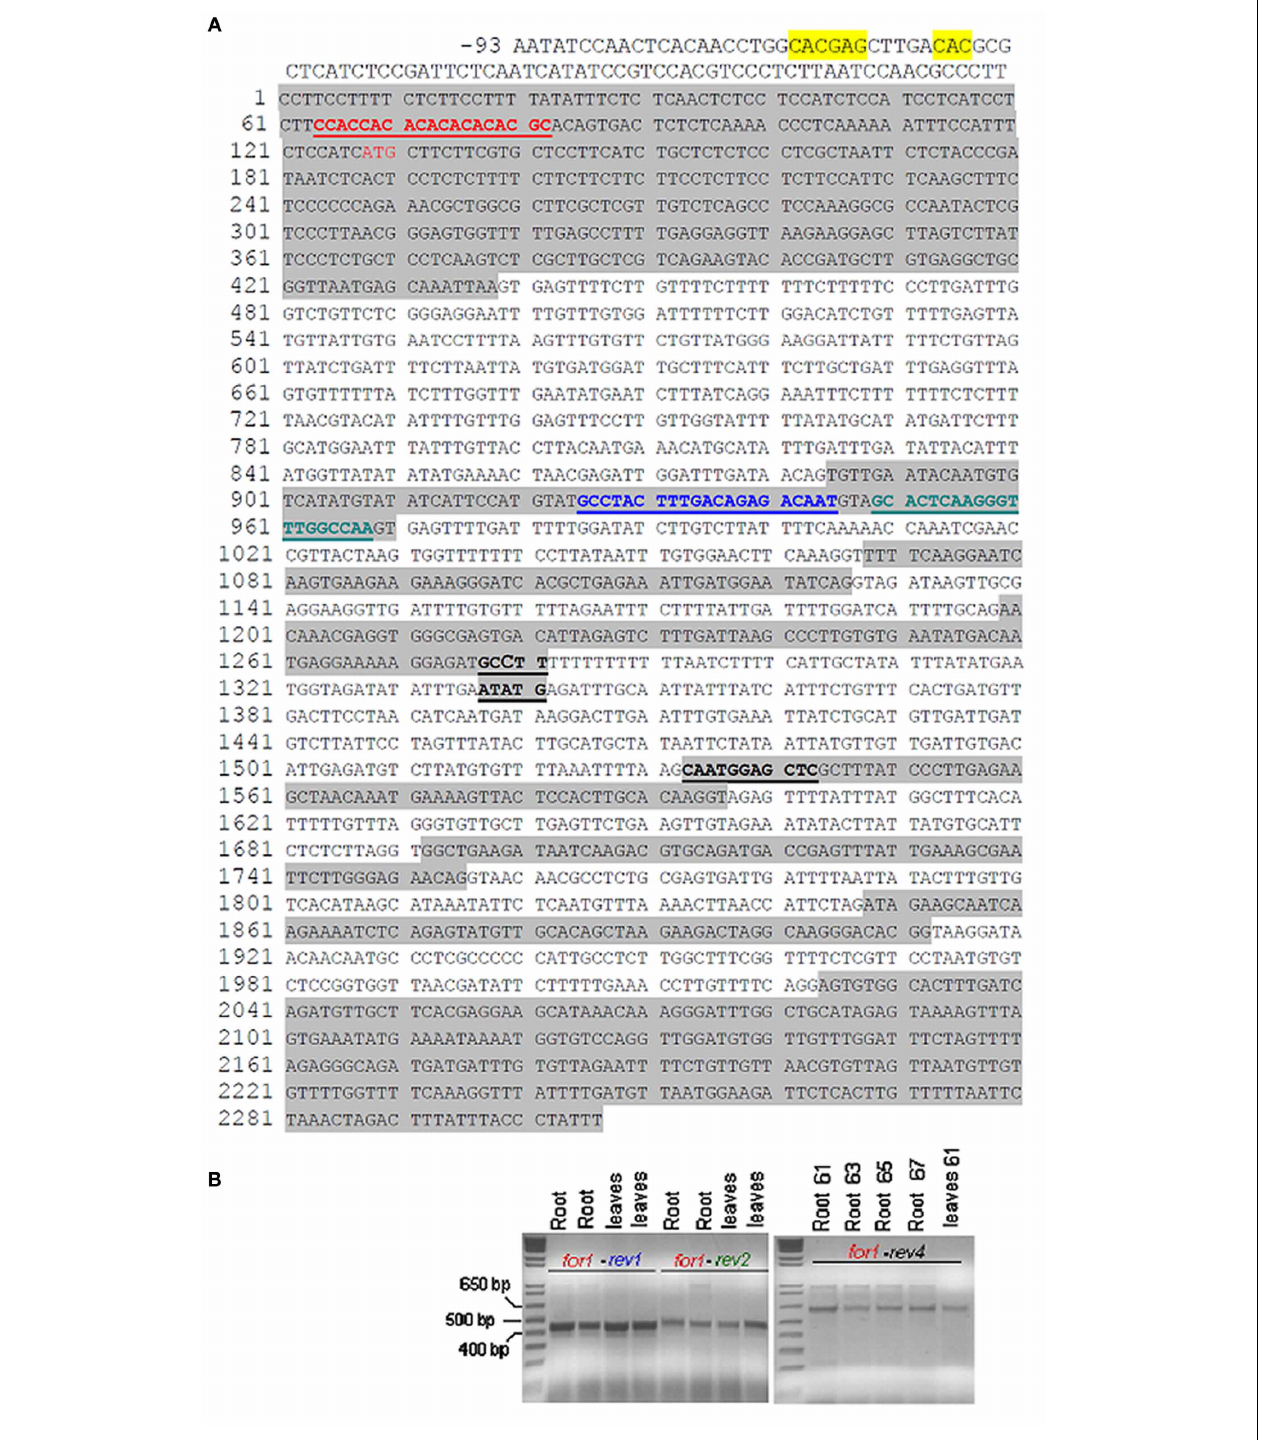
Cucsafor1-Cucsa-rev2, with either two independent RNA extracts from Fe-excess cucumber roots or two independent RNA extracts from Fe-excess leaves. The Kb ladder Plus (Invitrogen) has been loaded in the far left lane. Right panel: RT-PCR reactions with primer pair Cucsafor1-Cucsa-rev4, with RNA purified from Fe-excess roots at 61, 63, 65, 67 anneal. temp., or with RNA purified from Fe-excess leaves at 61 ◦ C anneal.